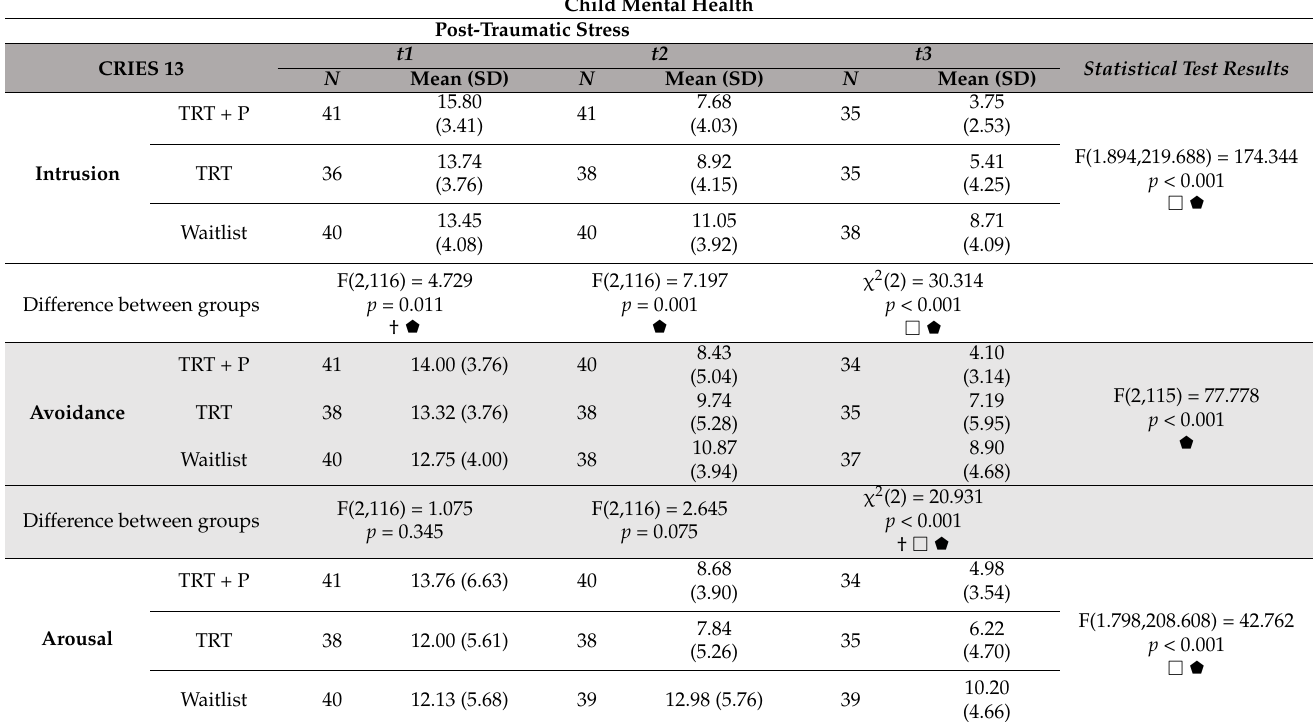
Table 2. Rating on mental health scales and subscales of children (CRIES 13, DSRS, and SCARED) and caregivers (SCARED, SDQ, IES-R, DASS, PS, and PSOC) by intervention group over time (t1 = pre-test, 1 week before the intervention; t2 = 2 weeks post intervention; t3 = 12 weeks post intervention